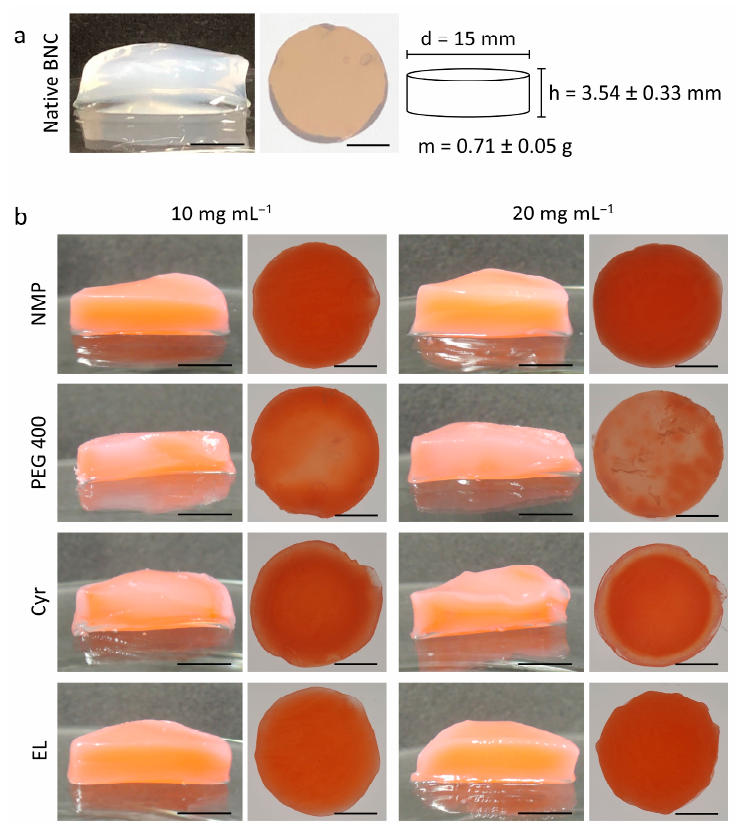
Figure 1. ( a ) Macroscopic cross-section and top view with the backlight of native BNC after synthesis and purification (scale bars = 5 mm), schematic depiction of diameter, height, and weight (mean ± SD, n = 50) of the used fleeces. ( b ) Macroscopic cross-section and top view with the backlight of BNC fleeces after in situ precipitation of PLGA using different organic solvents containing the lipophilic dye Sudan III (scale bars = 5 mm).